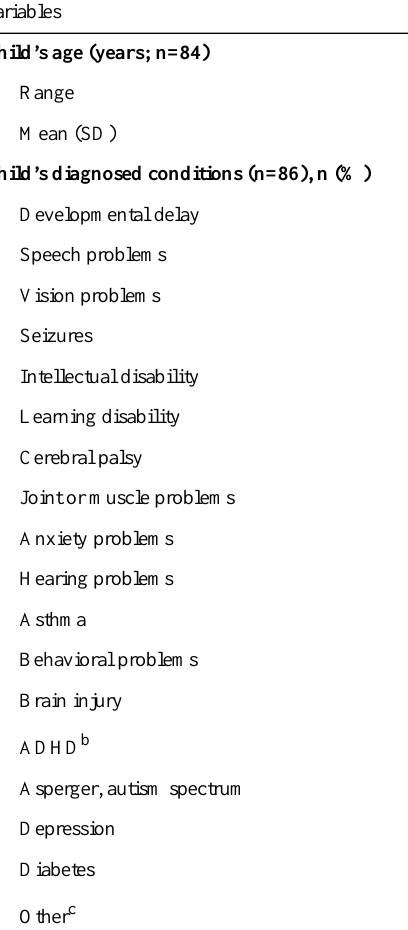
Table 1. Survey responses.